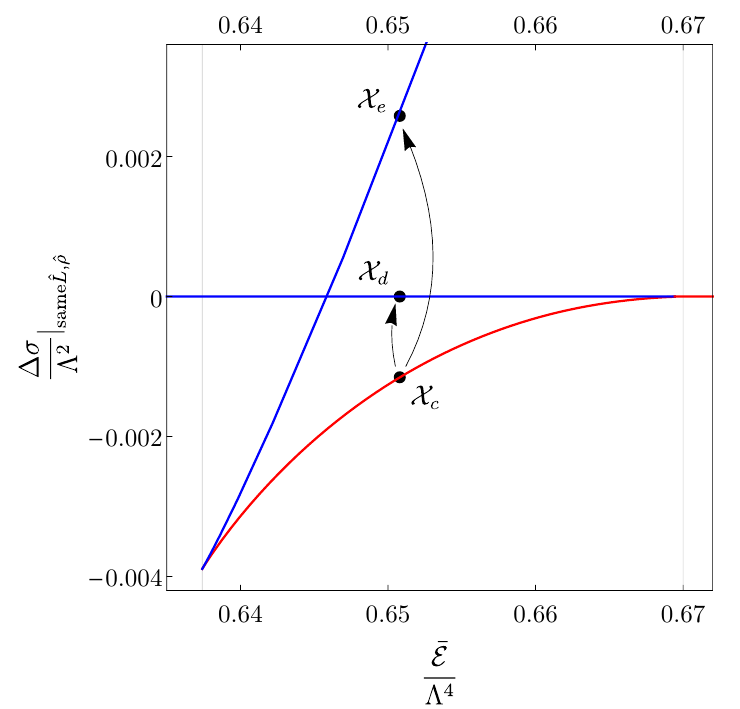
ˆ E ’ 0 . 651 . The nonlinear time evolution